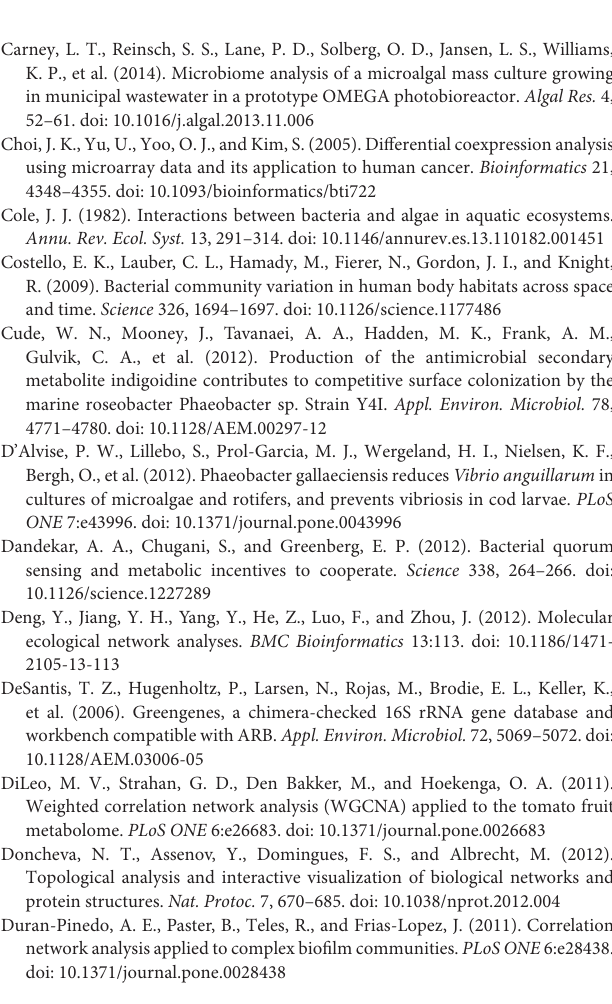
Figure S1 | Modules of OTUs in chemical treated microbiotas network. Hierarchical clustering dendrogram of OTUs was built based on dissimilarity based on nodes topological overlap. Modules have been colored by module